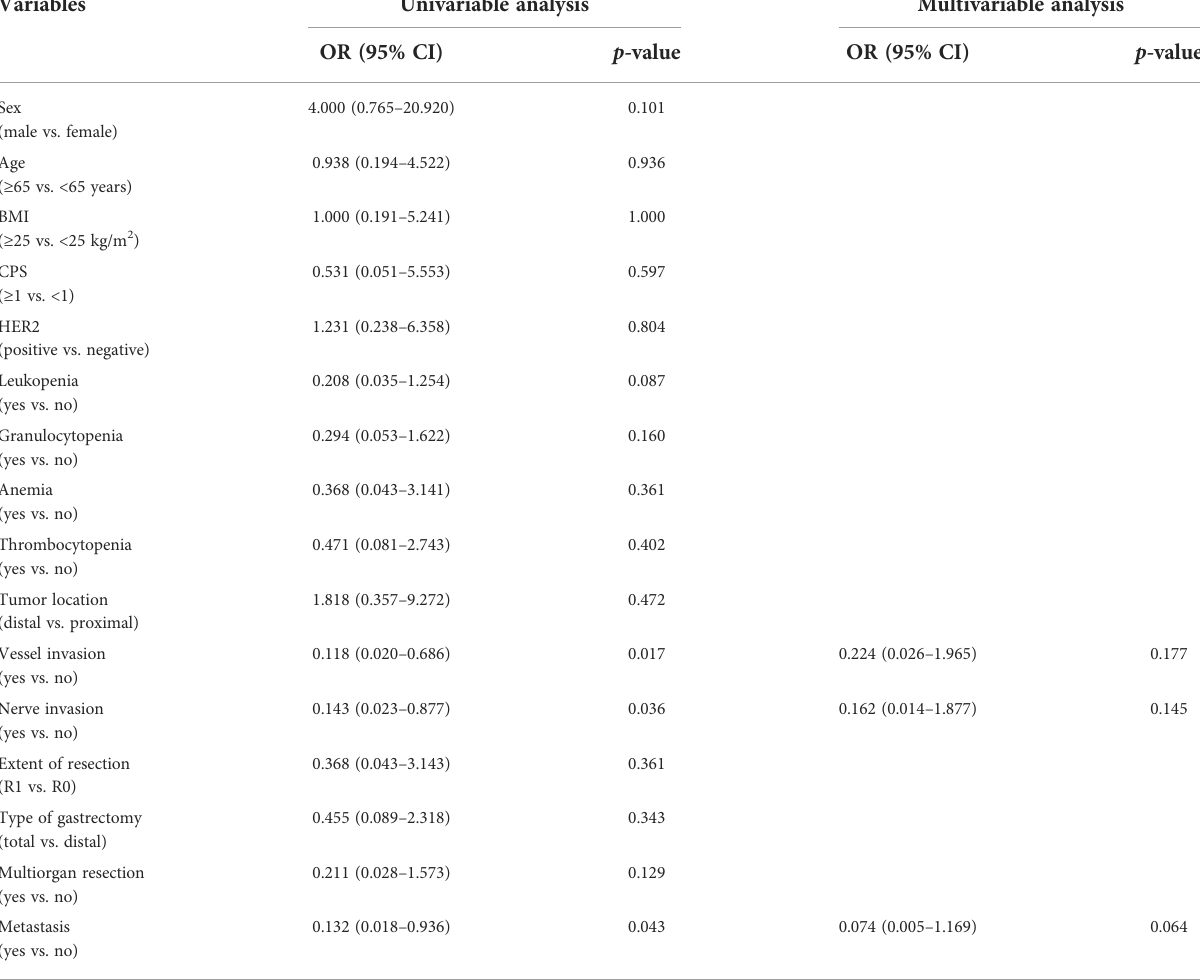
TABLE 6 Multivariable regression analysis of risk factors for the overall response rate to the NAI